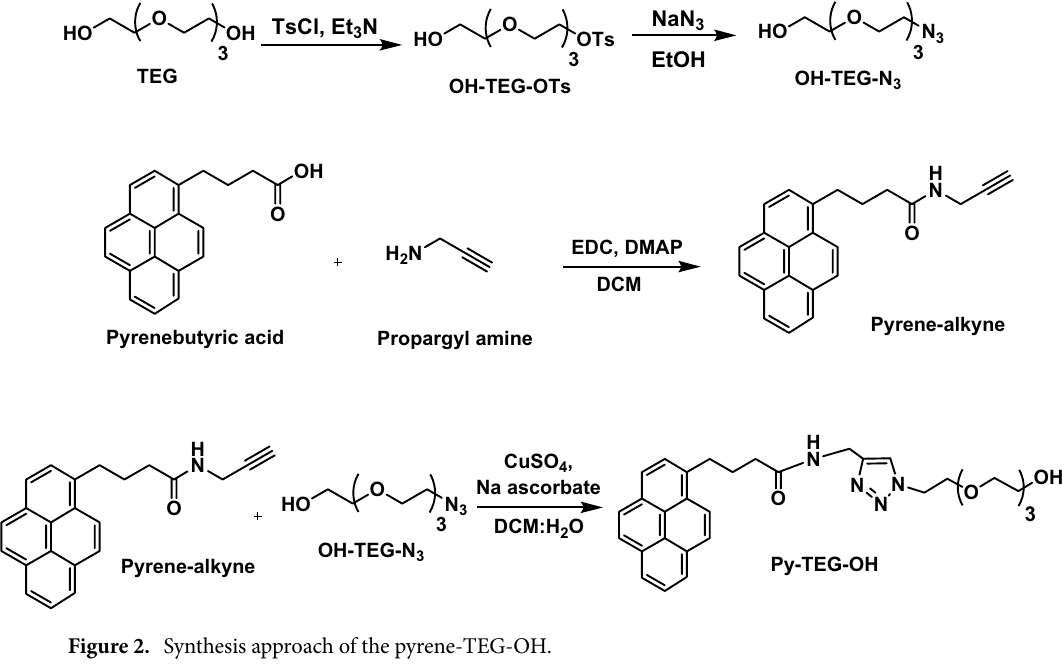
Figure 2. Synthesis approach of the